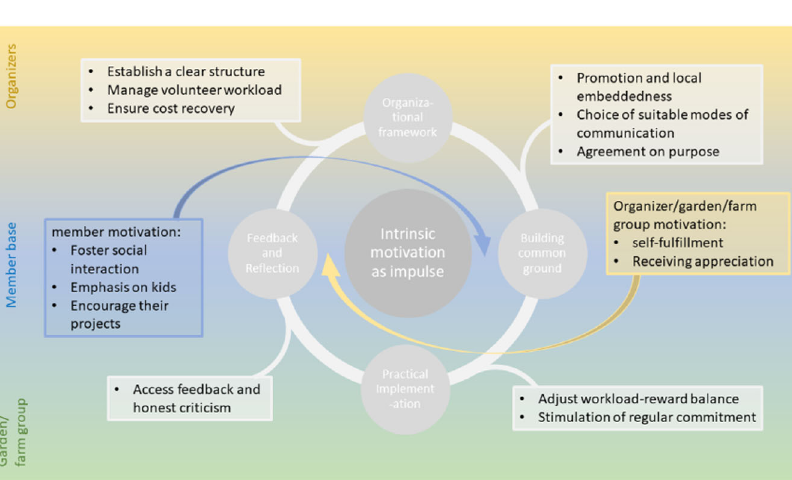
Fig. 3 The internal cycle of organisational adjustment in CSAs Organisers being the group of people who perform the main organisational and administrative tasks. The garden/farm group is part of the organisers but have a speci fi c responsibility, which differentiates them from the rest of the organisers. Member base describes the group of consumers who participate in the CSA. The grey bubbles show the most prominent phases of organisational adjustment with the white boxes indicating how the CSAs in the study moved from one phase to the next. The colour background is an indication of who plays the main role during each